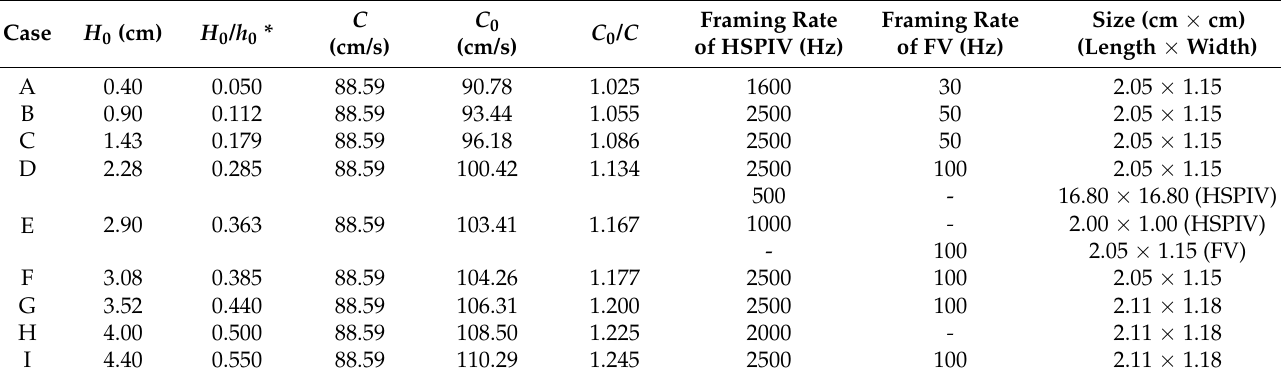
Table 1. A list of experimental